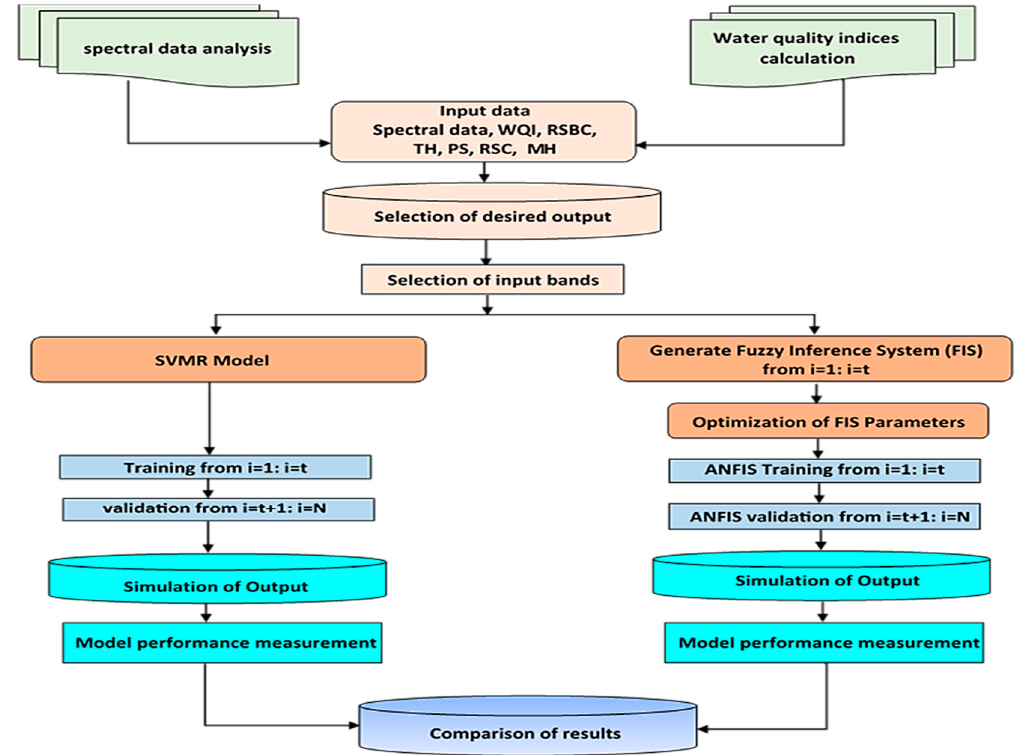
Figure 2. Schematic diagram of the methodology of support vector machine regression (SVMR) and adaptive neuro-fuzzy inference system (ANFIS) used in this study for estimating the groundwater quality variables. WQI, RSBC, TH, PS, RSC, and MR indicate water quality index, residual sodium bicarbonate, total hardness, potential salinity, residual sodium carbonate, and magnesium hazard, respectively.